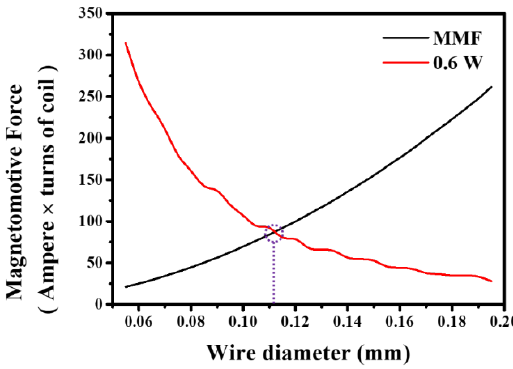
Figure 3. Simulation result of the solenoid coil: magneto-motive force vs. wire diameter.